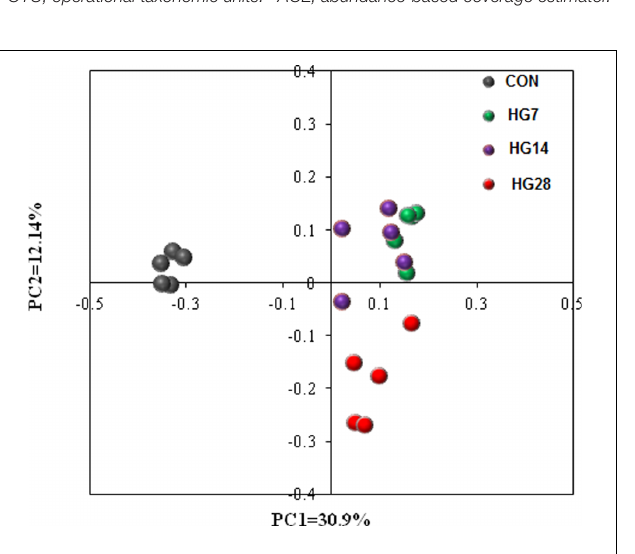
At the 97% similarity level, the OTU numbers, ACE value,